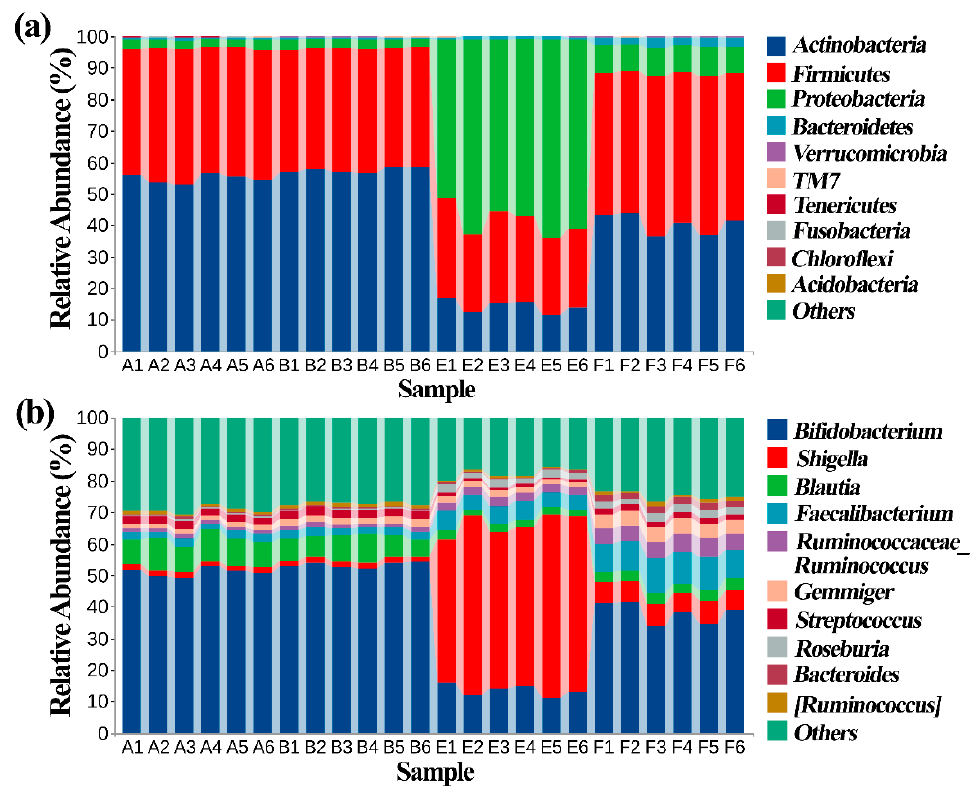
Figure 6. Assay of hierarchical clustering constructed at the levels of ( a ) phylum and ( b ) genus ac- cording to Bray–Curtis dissimilarity ( n = 6). A: healthy children; B: healthy children + ZnONP; E: ASD children; F: ASD children + ZnONP.